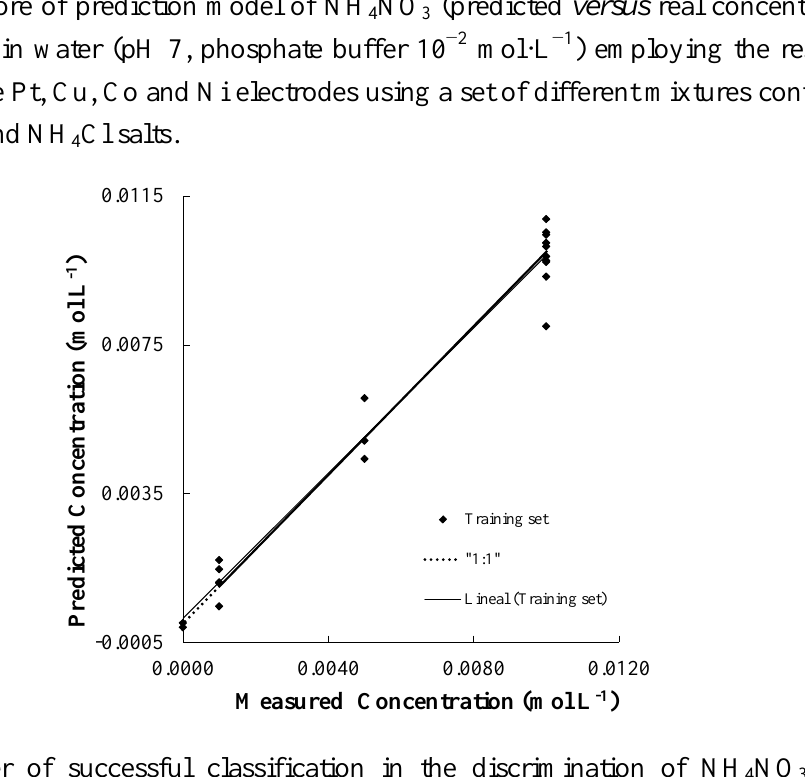
NO (predicted versus real concentration) 4 3